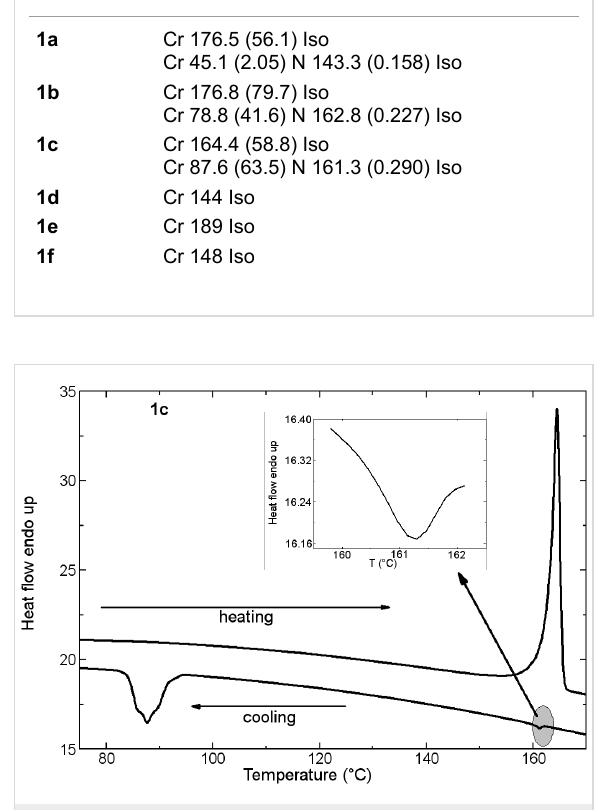
Figure 2: DSC trace of 1c obtained during initial heating and cooling cycles scanned at a rate of 10 K/min.